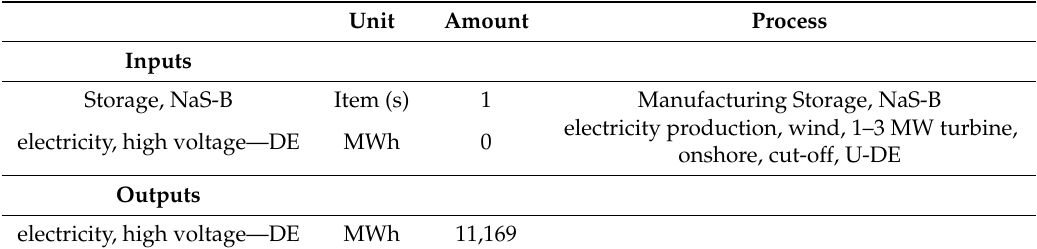
Table A29. Use Storage, NaS-B.